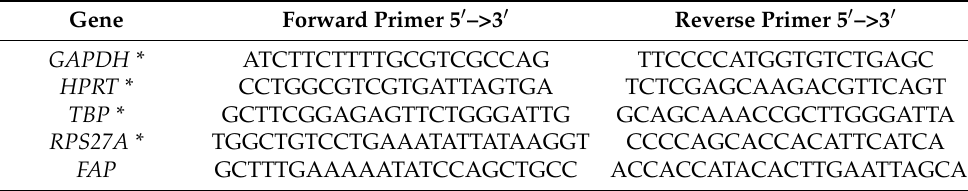
Table 1. Primer sequences used in this study. Reference genes are marked with an asterisk (*).